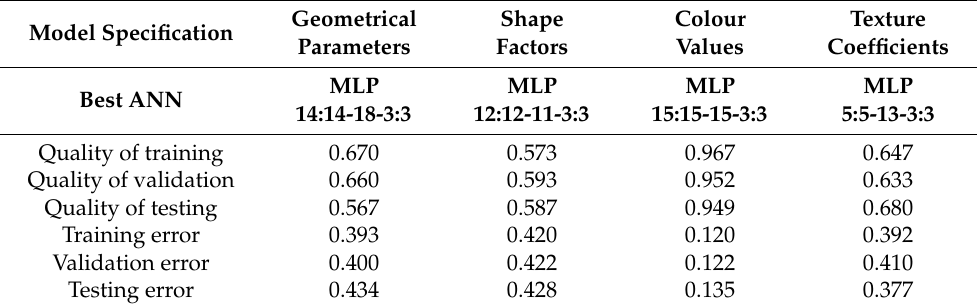
Table 2. The preliminary outcomes of neural network processing using the Neural Network Toolbox.